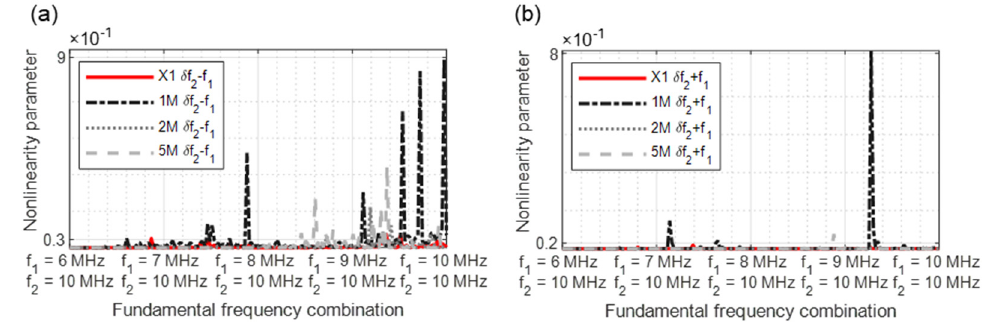
− f 2 1 ; ( b ) δ f 2 + f 1 .